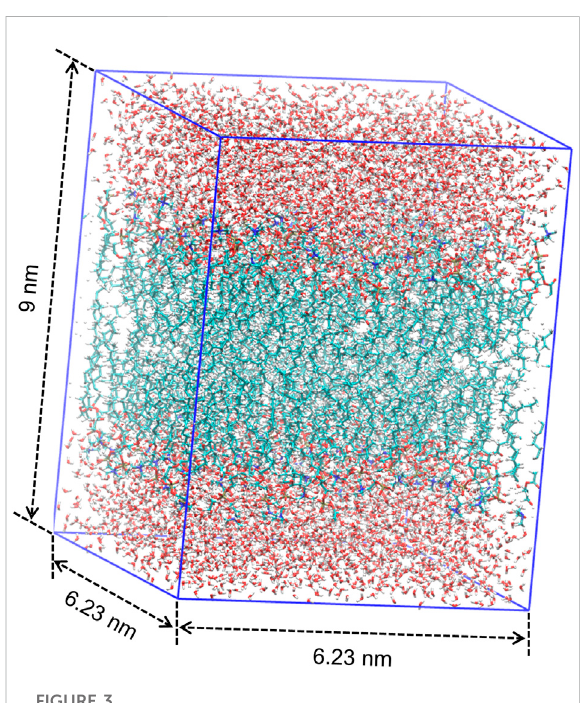
Final structure of the equilibrated membrane-water